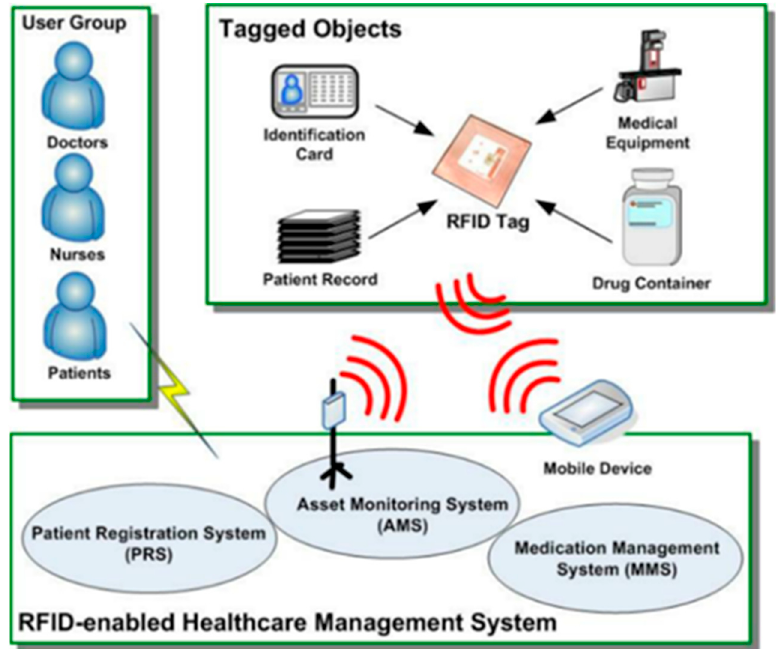
Figure 1. RFID performance scheme at a health center [2].